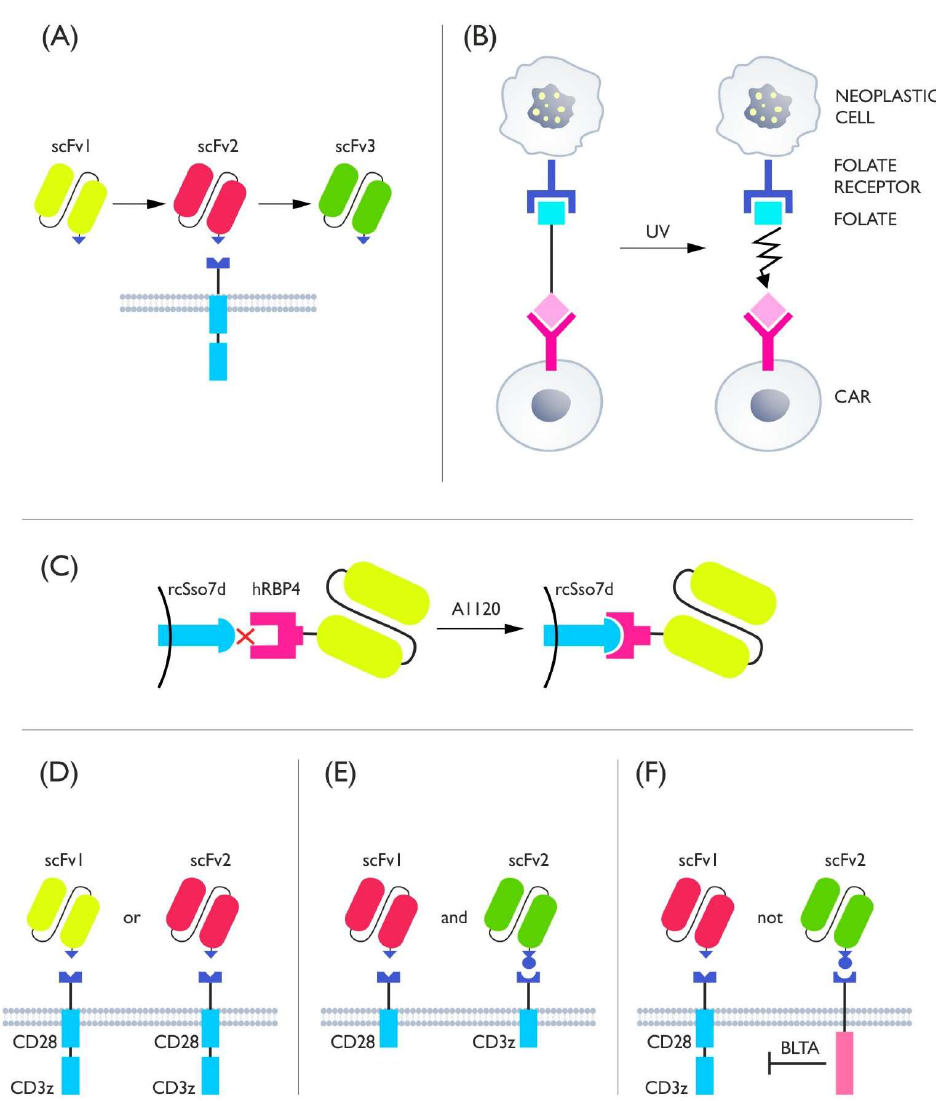
Figure 5. ( A ) Schematic of the universal receptor idea. One CAR is able to bind multiple mediators having identical endings but different binding domains. In this system, CAR does not directly recognize the tumor antigen—it does so indirectly via the appropriate trans molecule. ( B ) The mediator consists of FITC which is the target for CAR and folate which binds to its receptor on the tumor. The mediator is connected by a chemical bond that leads to the degradation of the TM and inactivation of CAR upon UV delivery. ( C ) CAR has a rcSso7d domain that does not naturally bind to hRBP4, which is a component of the TM. When A1120 is added, the conformation of hRBP4 is changed so that it binds to hRBP4 on CAR allowing for a cytotoxic effect. ( D ) OR gate: one type of CAR supplied with two (or more) mediators; one receptor binds many different types of TMs. ( E ) AND gate: CAR splits into a domain containing CD28 (costimulatory part) and CD3z (signaling domain); both receptors need to be stimulated for the cell to be activated, and both receptors have different binding abilities for TM which means that different mediators are needed to activate them. ( F ) NOT gate: if a second signal is recognized, BLTA blocks activation of the stimulating receptor, and the two receptors have different binding abilities to the TM which makes them require different mediators and antigens for